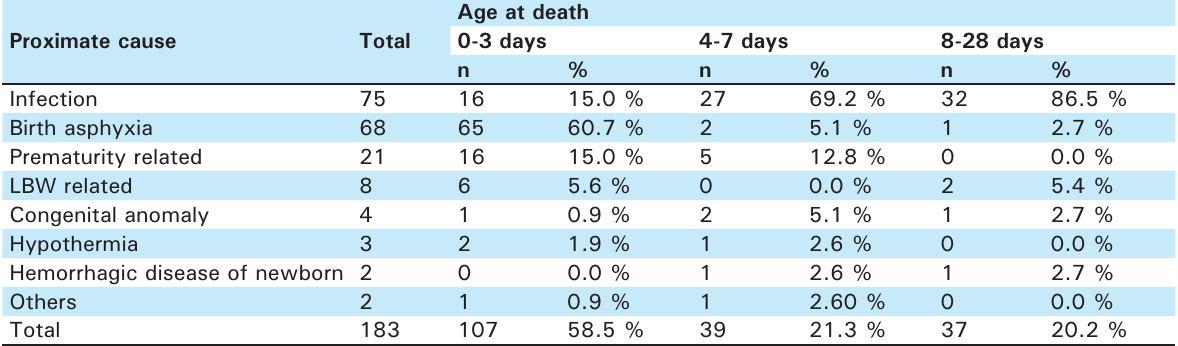
Table 3: Cause of death by place of delivery: Institutional Vs Home delivery